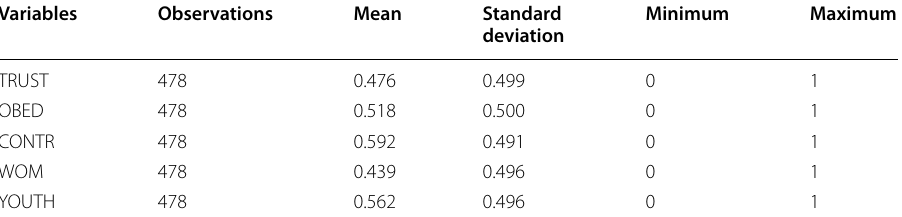
Table 8 Descriptive statistics. Source : Authors computations, 2022 Variables